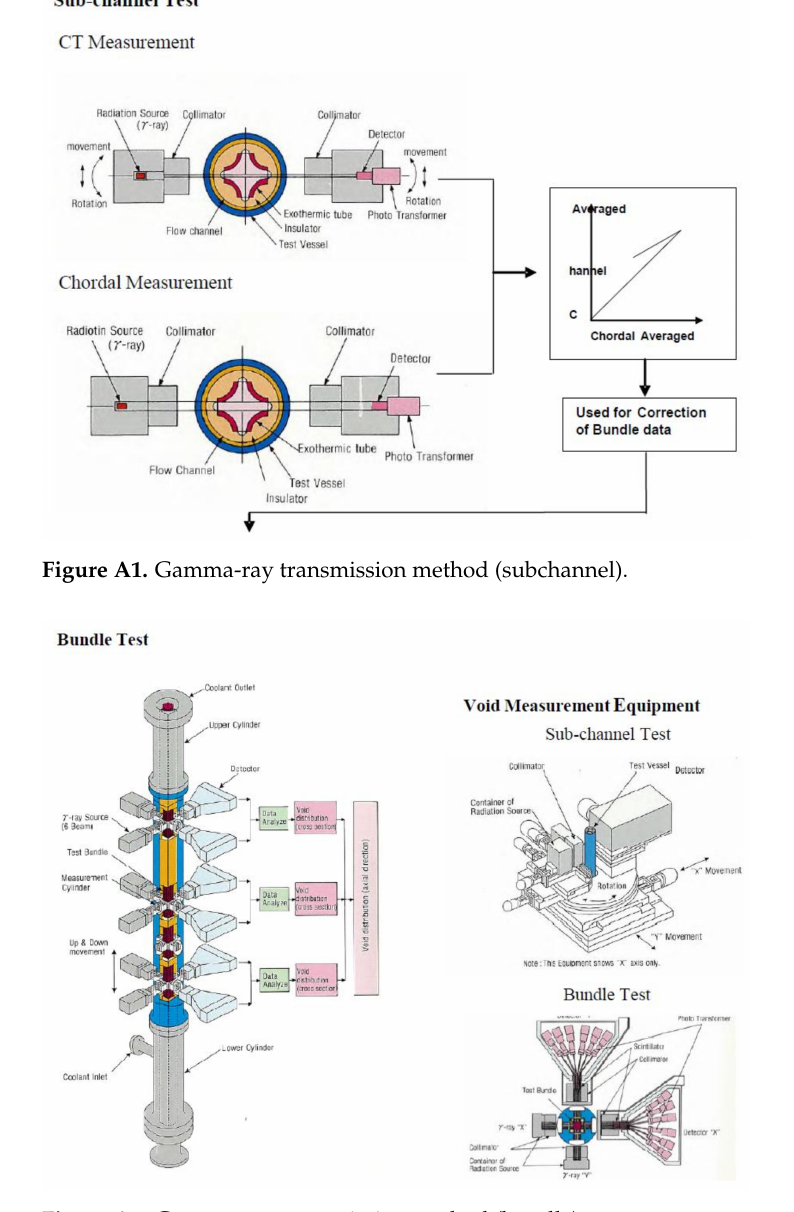
Figure A2. Gamma-ray transmission method